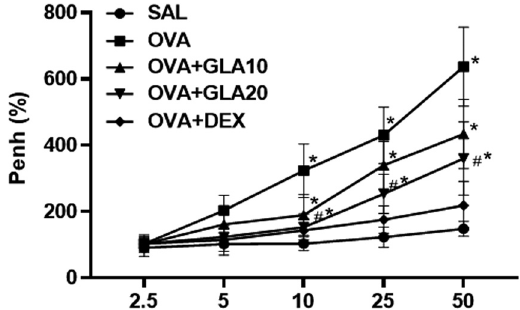
Figure 3: E ff ects of GLA on the airway hyperresponsiveness ( AHR ) to methacholine. The baseline Penh of the SAL - treated control group is considered 100%. The percentage increase in Penh over the base - line is shown. N = 3; # P < 0. 01 vs the SAL group; * P < 0.05 vs the OVA group; analyzed by